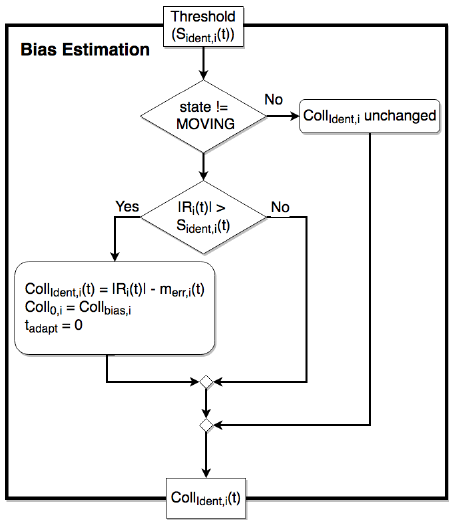
Figure 9. Activity diagram of the bias estimation block for the i -th joint.